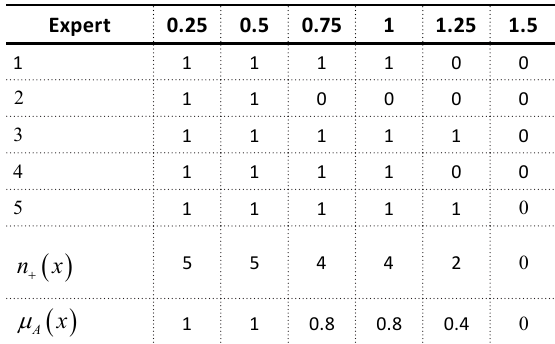
Table 1. Experts answers to a question: “What value of the current ratio indicates a high risk of bankruptcy?”